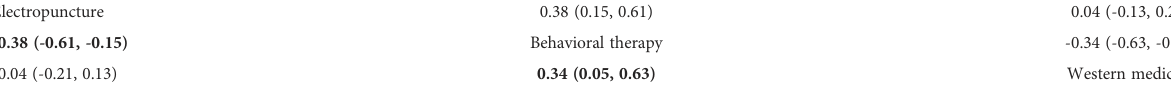
TABLE 15 Network meta-analysis ladder table of low-density lipoprotein.